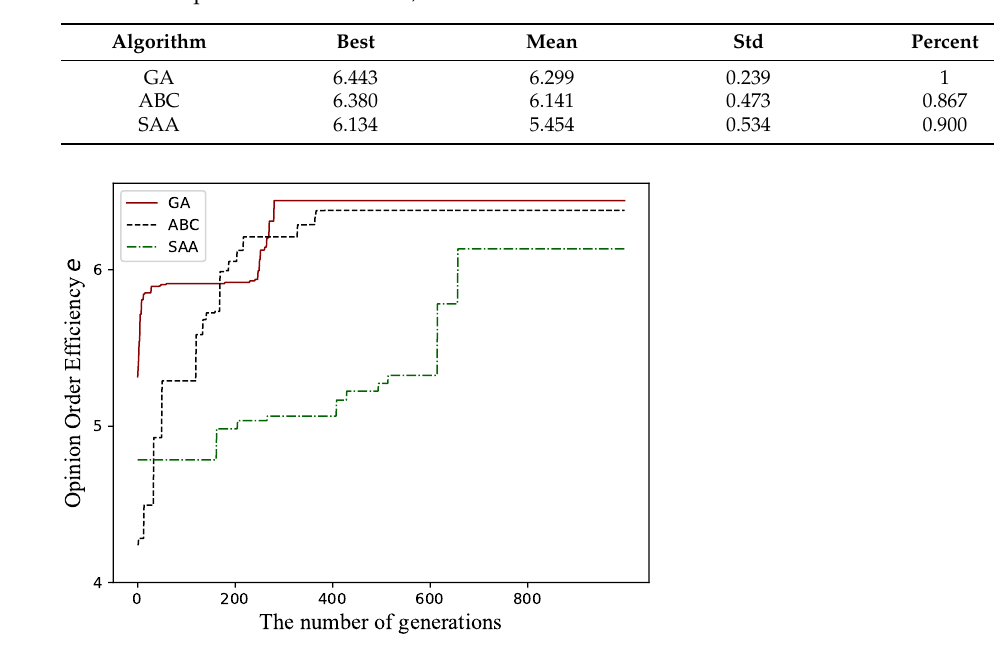
Figure 5. Convergence curves of GA, ABC and